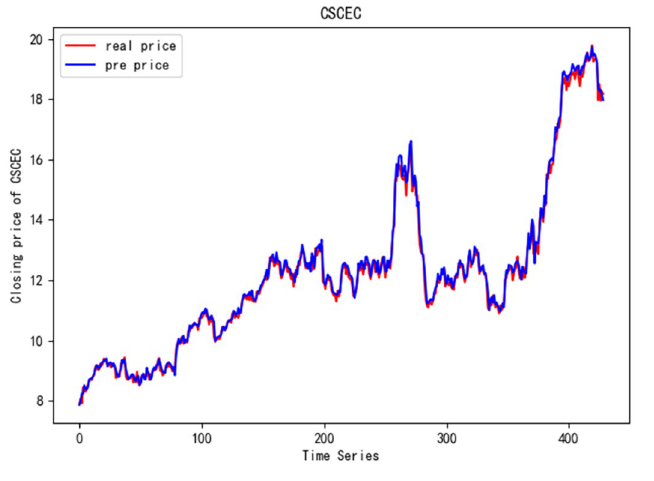
Fig 10. Closing price of